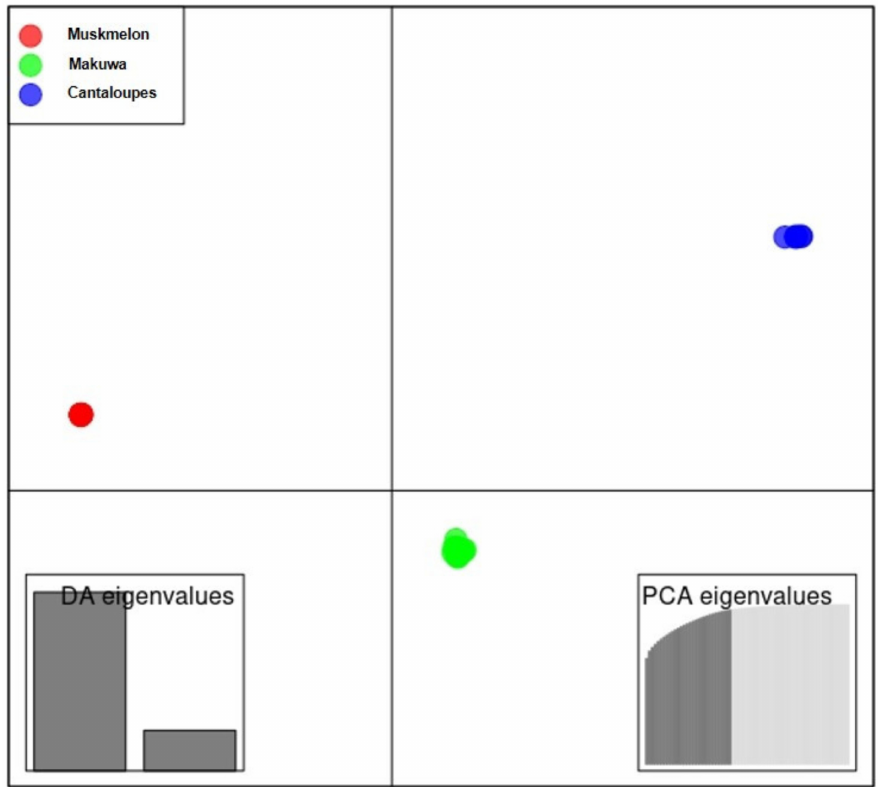
Figure 1. Discriminant analysis of principal components (DAPC) for 72 melon accessions using 6406 single nucleotide polymorphisms (SNPs). Eight first principal components (PCs) and three discriminant eigenvalues were retained during the analyses to describe the relationship between the clusters. The axes represent the first two linear discriminants (LD). Each circle represents a cluster and each color represent the different subpopulations identified by the DAPC.